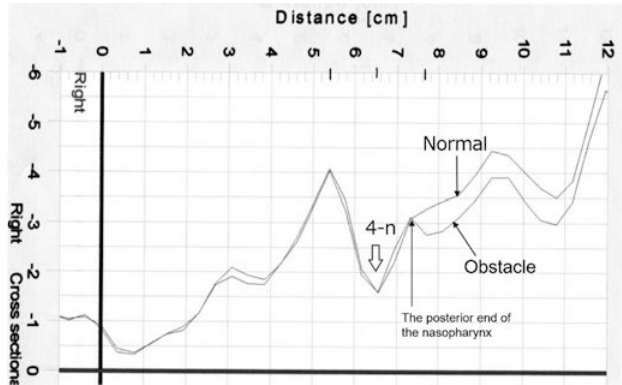
Figure 6 Changes in the area–distance curve with an obstacle at the posterior end of the nasopharynx. The obstacle at the posterior end of the nasopharynx was detected at 8 mm posterior to the fourth notch on the area–distance curve.